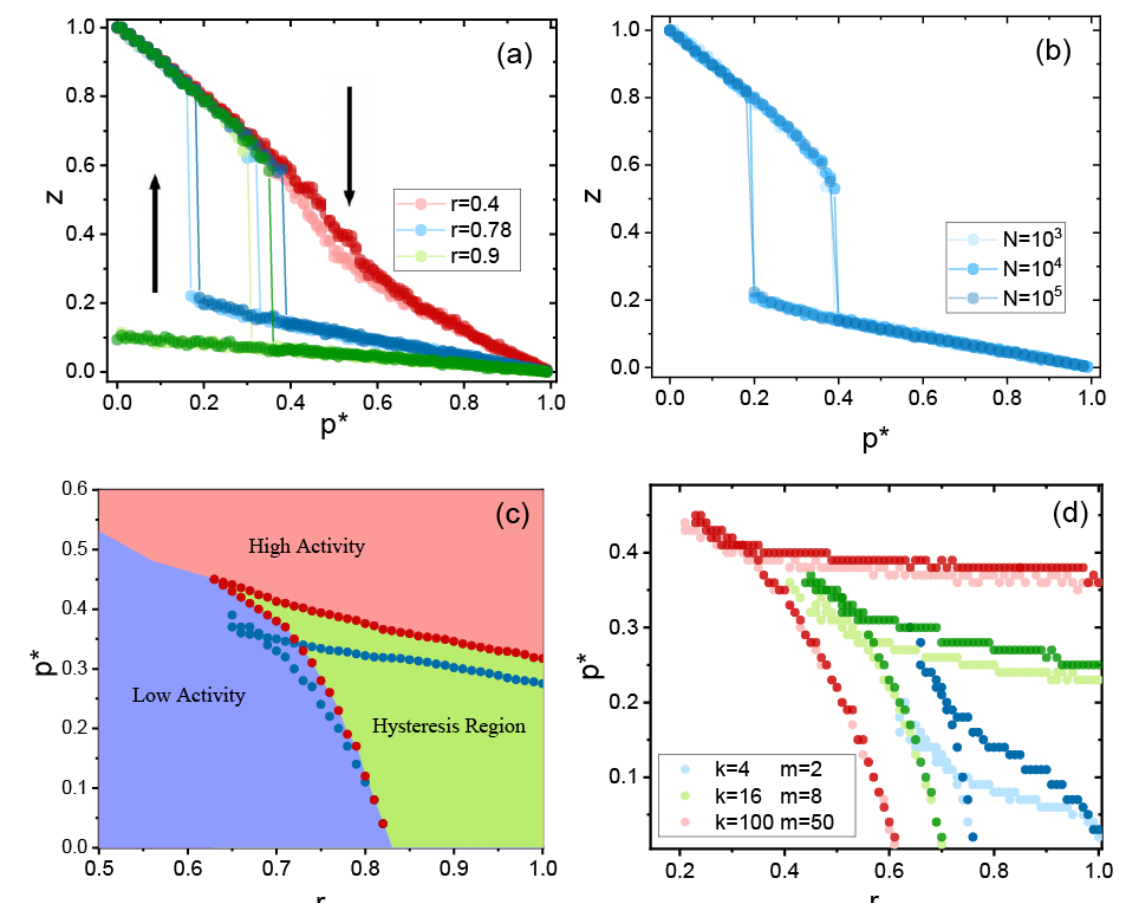
Figure 3. Phase diagrams of the RR network. ( a ) Simulation results of the average fraction of nodes for three different r values under LA (dark symbols) and RA (light symbols). The parameters for the RR network are < k > = 10, m = 4, and N = 10 5 . ( b ) Simulation results of the average fraction of nodes for three different r values under LA for different N with < k > = 10, m = 4, and r = 0.78. ( c ) The phase diagram in model parameters ( r , p ∗ ) exhibits two kinds of phase transition behaviours. Low- and high-activity correspond to the cases where the fraction of active nodes of the stationary state is small or large, respectively. Red points are the dividing points between the hysteresis region and high/low-activity regions under LA. Additionally, two bunches of red points merge at a critical point located at ( r = 0.63, p ∗ = 0.45). Blue points are the similar results under RA. ( d ) Jump points for different parameters. Light points are RA, and dark points are LA. Simulation results have been averaged over 1000 network realisations.